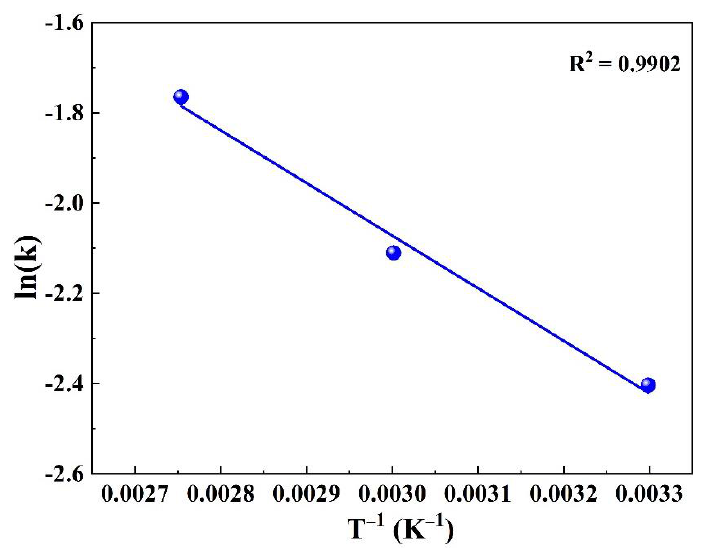
Figure 9. Relationship between the leaching rate constant k and temperature T .